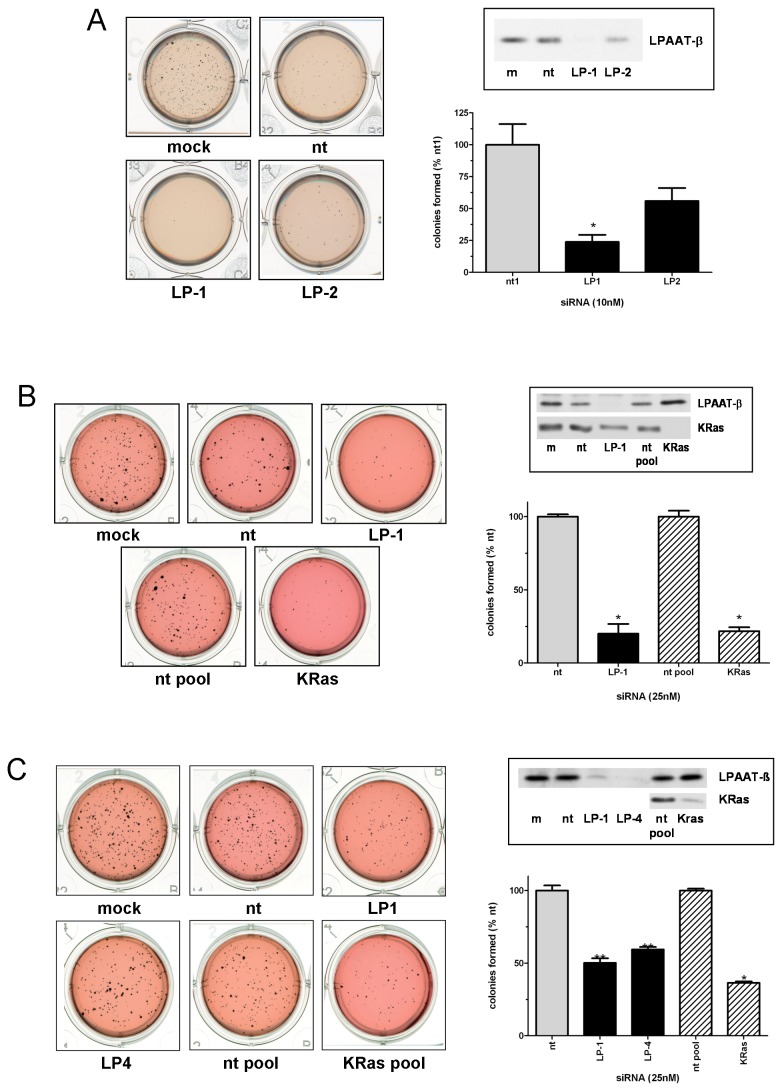
Knockdown of LPAAT-β protein expression results in inhibition of anchorage-independent growth of pancreatic cancer cells.Inhibition of anchorage-independent growth was determined by plating (A) AsPC-1, (B) Panc-1, or (C) MiaPaCa2 cells onto a soft agar matrix after 48 hr (AsPC-1) or 72 hr (Panc-1 and MiaPaCa2) transfection with the indicated siRNA (non-targeting: nt and nt pool; LPAAT-β: LP-1, LP-2, LP-4; and KRas. Insets show confirmation of the knockdown of target proteins. Statistical significance was measured using Student’s t-test comparing the target siRNA samples to their appropriate nt control siRNA; * p < 0.0001; ** p = 0.0005.